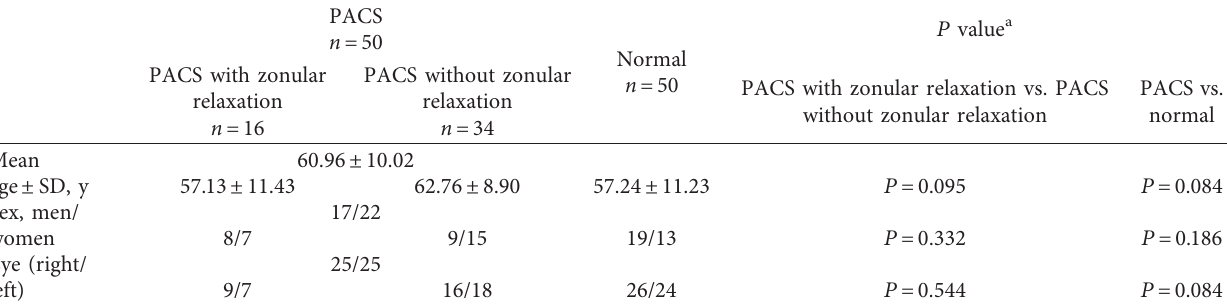
Table 1: Basic information of study